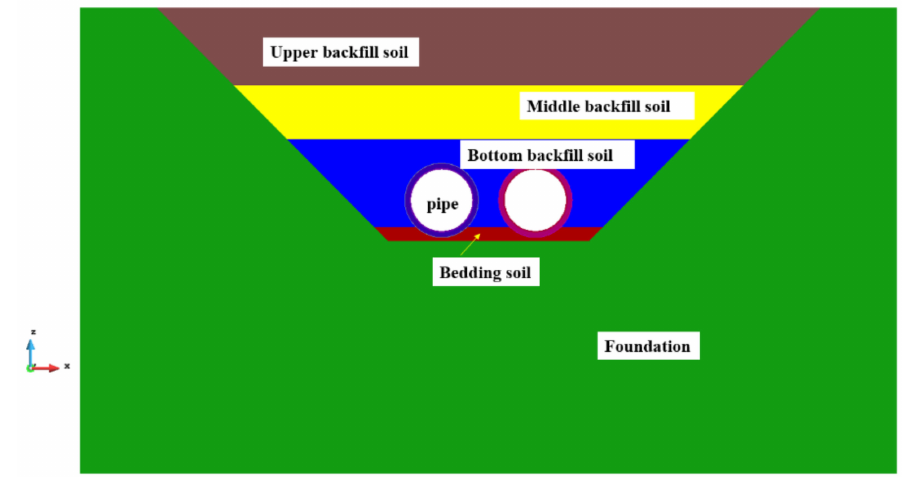
Figure 7. The backfill diagram of FEA model (pipe No.1).